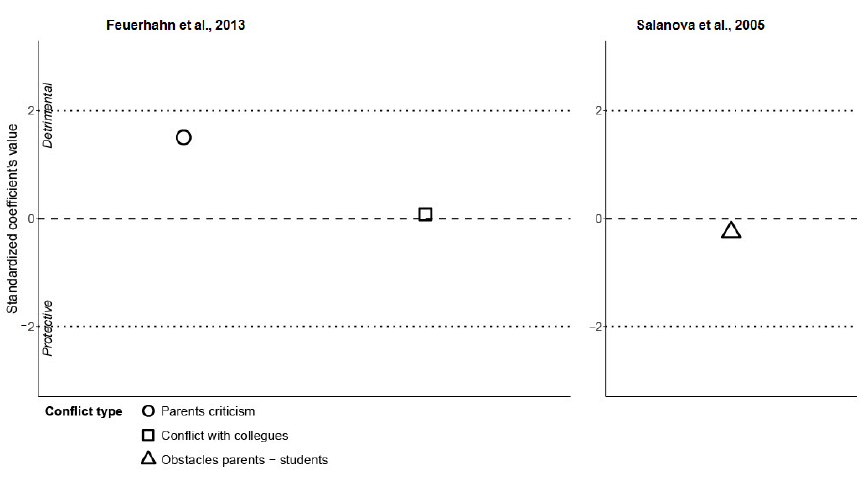
Figure 3. Studies showing conflict category of burnout determinants (Feuerhahn et al., 2013; Salanova et al., 2005) [48,49].